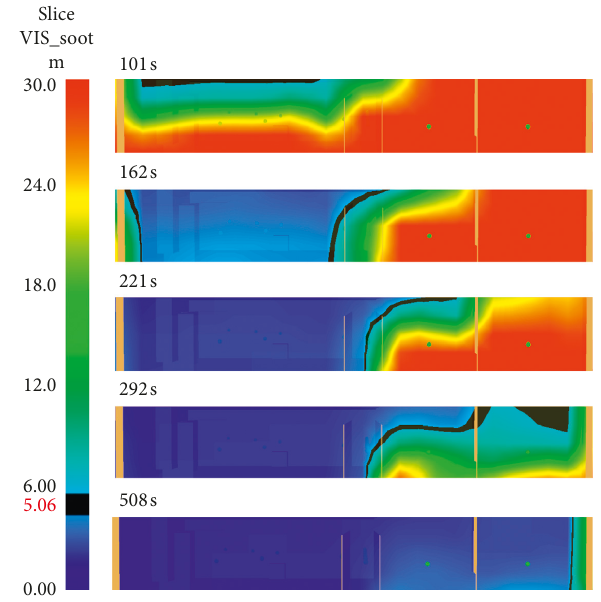
Figure 10: Visibility slice of fire scenario D10.